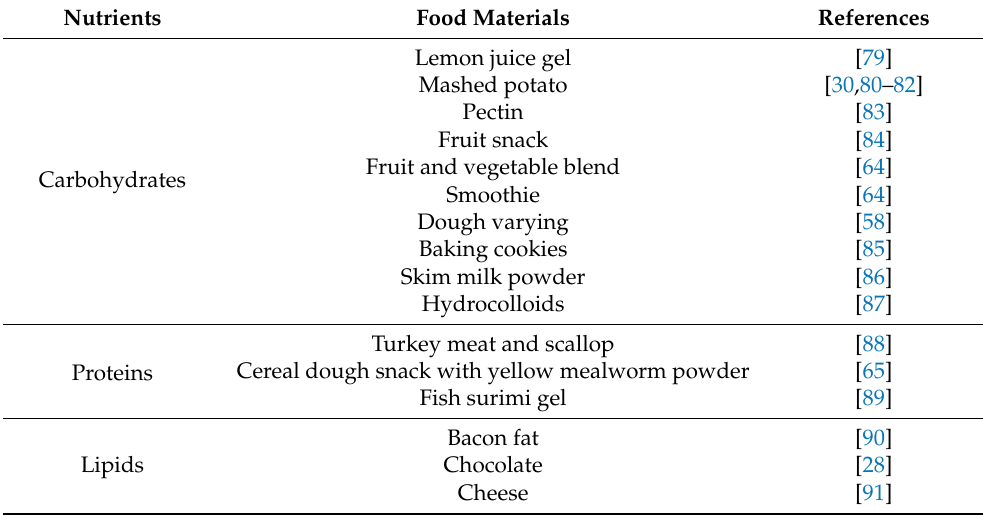
Table 4. Various food materials utilized for extrusion-based 3D